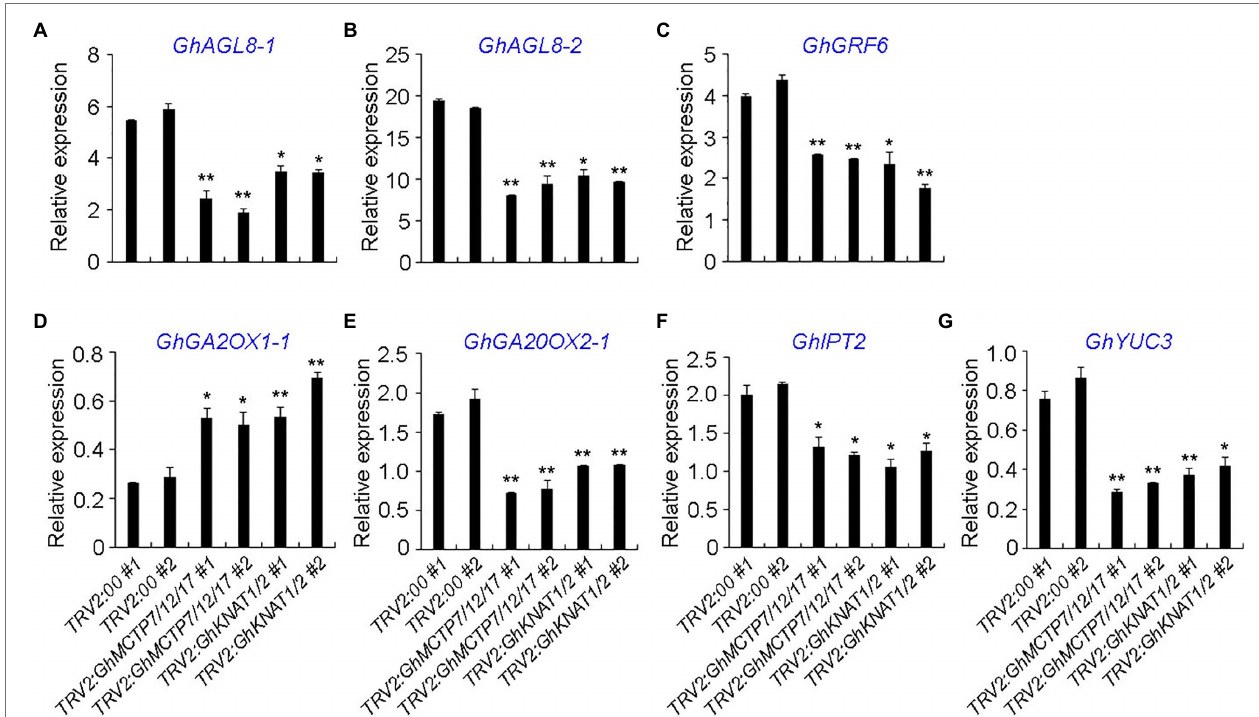
FIGURE 9 | Quantitative analysis of multiple shoot meristem regulators in main stem apex of TRV2:00 , TRV2:GhMCTP7/12/17 , and TRV2:GhKNAT1/2 plants. The expression levels of GhALG8-1 (A) , GhAGL8-2 (B) , GhGRF6 (C) , GhGA2OX1-1 (D) , GhGA20OX2-1 (E) , GhIPT2 (F) , and GhYUC3 (G) in TRV2:GhMCTP7/12/17 and TRV2:GhKNAT1/2 plants. Results were normalized against the expression level of GhUBI1 . Error bars indicate SD of three biological replicates (* p < 0.05; ** p <